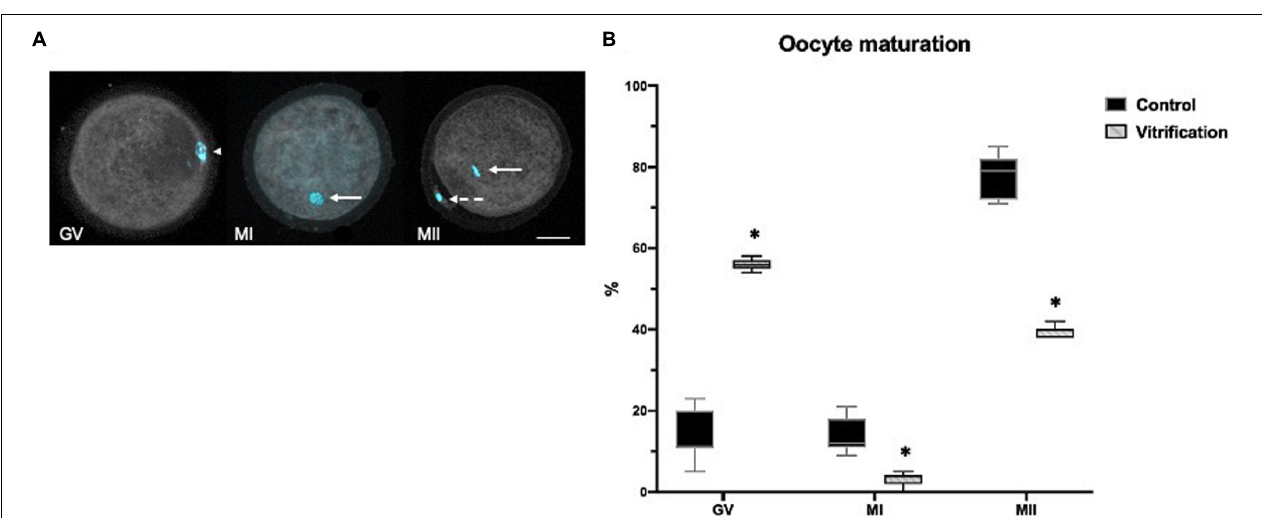
FIGURE 2 | Oocyte in vitro maturation (IVM) evaluation by Hoechst staining in control and vitrified groups: (A) representative image for oocyte IVM evaluation criteria (oocytes were classified as: arrowhead shows germinal vesicle (GV), continuous arrow shows metaphase I (MI), continuous arrow shows metaphase II (MII), and the dotted arrow show the polar body; 400 × , scale bar = 30 µ m; (B) percentage of oocyte IVM; the total numbers of evaluated cells in the control and vitrification groups were 256 and 143, respectively. ∗ Significant difference vs. control. P <